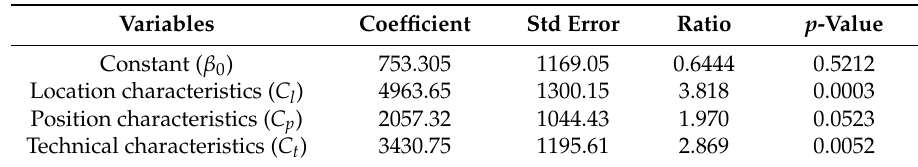
Table 4. The value function of touristic market segment, robust standard errors with respect to heteroskedasticity, HC1 variant.